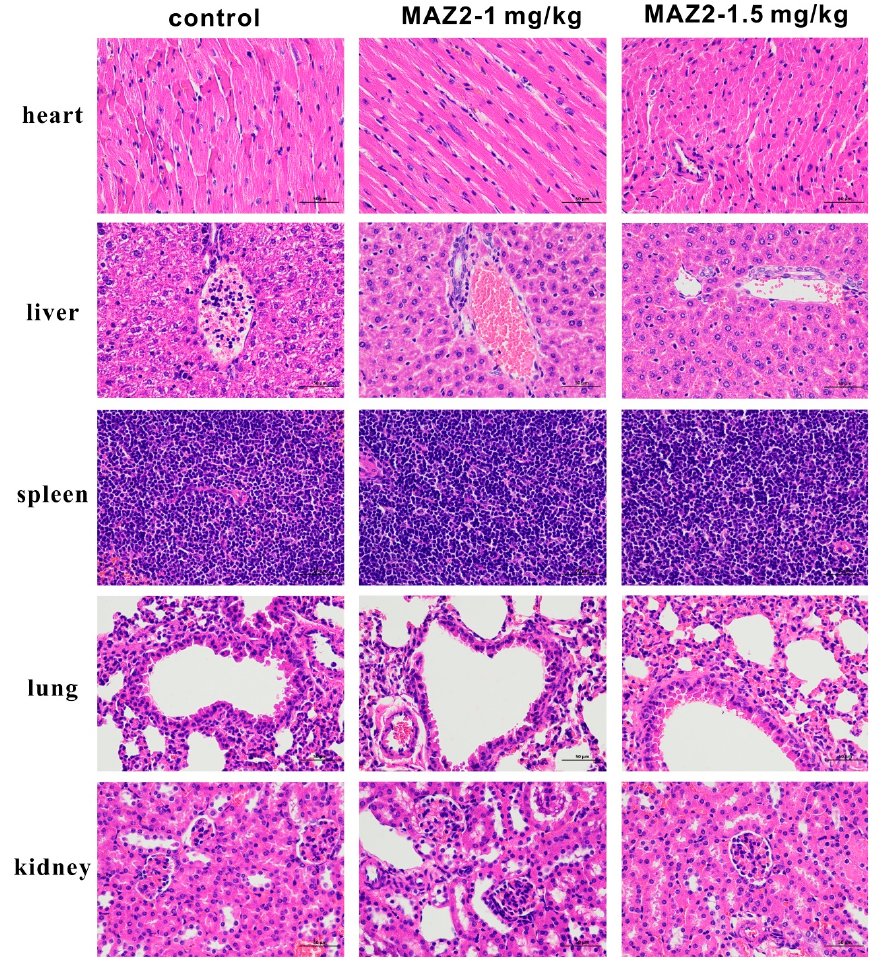
Figure 7. H&E staining of the heart, liver, spleen, lungs, and kidneys from the three groups.